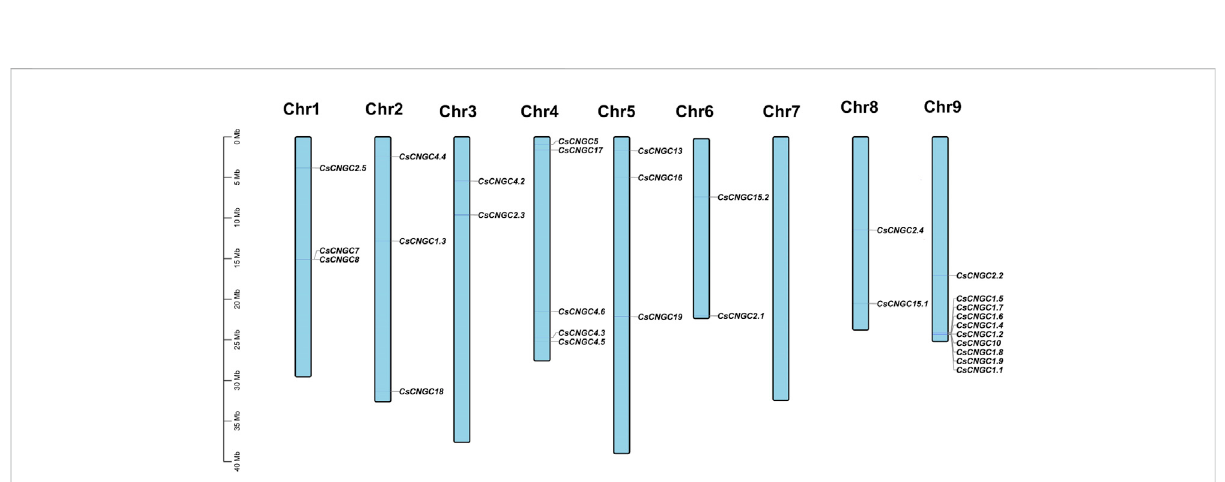
FIGURE 5 Distribution of CsCNGC genes on chromosomes. Genes get mapped on chromosomes based on information available at the Citrus pan- genome to breeding database. Chromosome numbers are indicated at the top of each chromosome. The scale is given in Megabases (Mb).